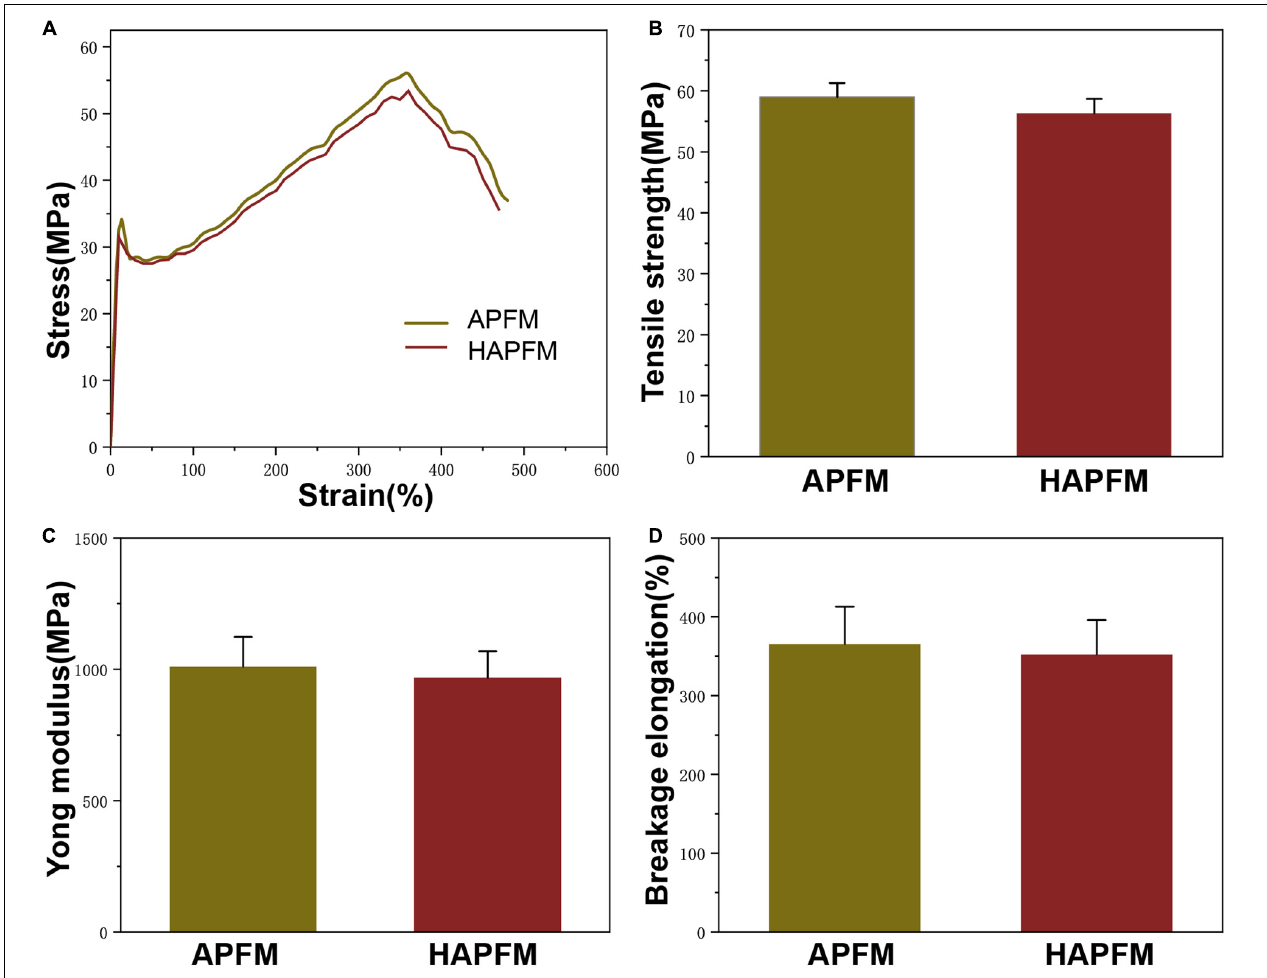
FIGURE 3 | Mechanical properties. (A) Tensile stress–strain curve of APFMs and HAPFMs. (B) Tensile strength of APFMs and HAPFMs ( n = 5, p > 0.05). (C) Young’s modulus of APFMs and HAPFMs ( n = 5, p > 0.05). (D) Breakage elongation of APFMs and HAPFMs ( n = 5, p > 0.05). APFMs, aligned poly ( L -lactic acid) fiber mats; HAPFMs, highly aligned poly( L -lactic acid) fiber mats.